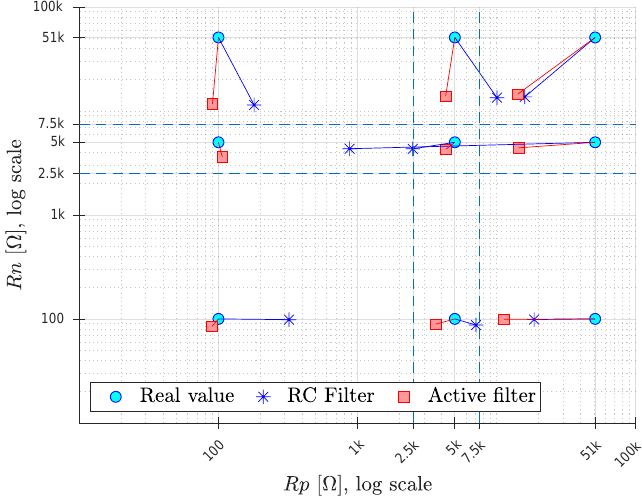
Figure 9. Resistance assessment result, with a switching period of 1s. The cyan dots are the real values of the contact resistance, the red squares are those estimated using the active filter, and the blue stars are the values estimated with the RC